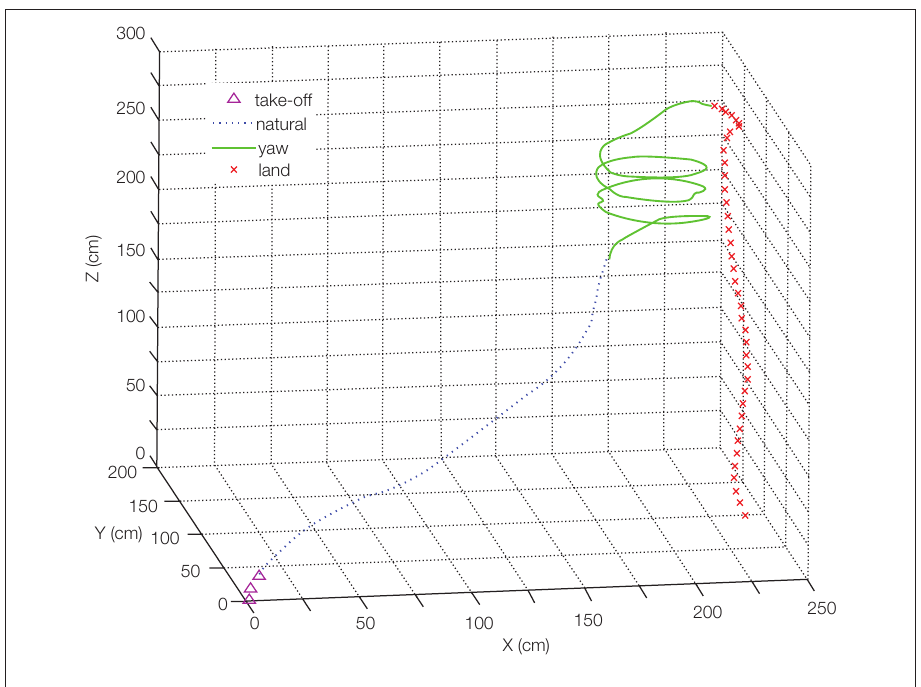
FIguRe 5 | Digitized flight track of the balloon assisting moth hybrid system as in Figure 2 as a result of applied stimulation pulses. Reproduced from Bozkurt et al.